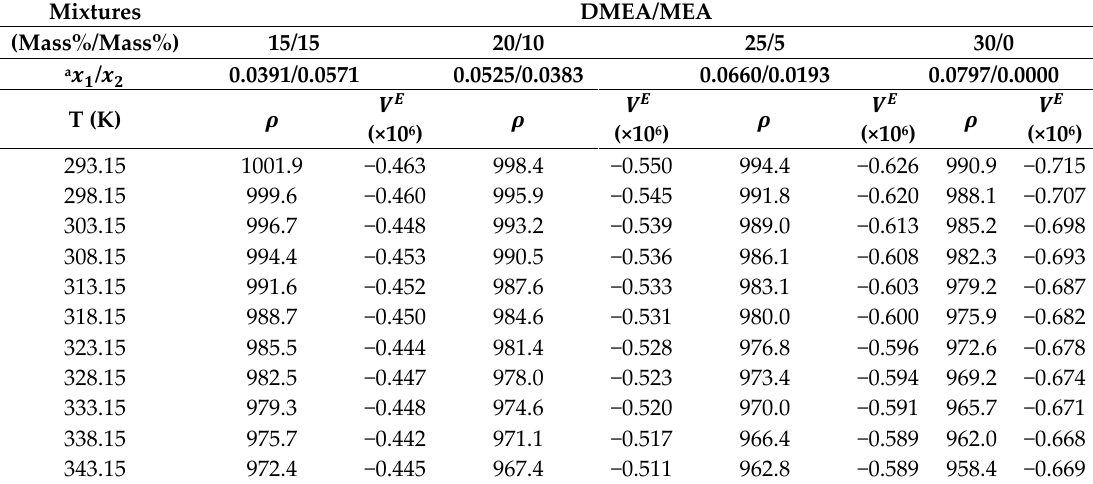
Table 4. Densities 𝜌 (kg · m −3 ) and excess molar volume 𝑉 𝐸 (m 3 · mol −1 ) of DMEA (1) + MEA (2) + H 2 O (3) mixtures.